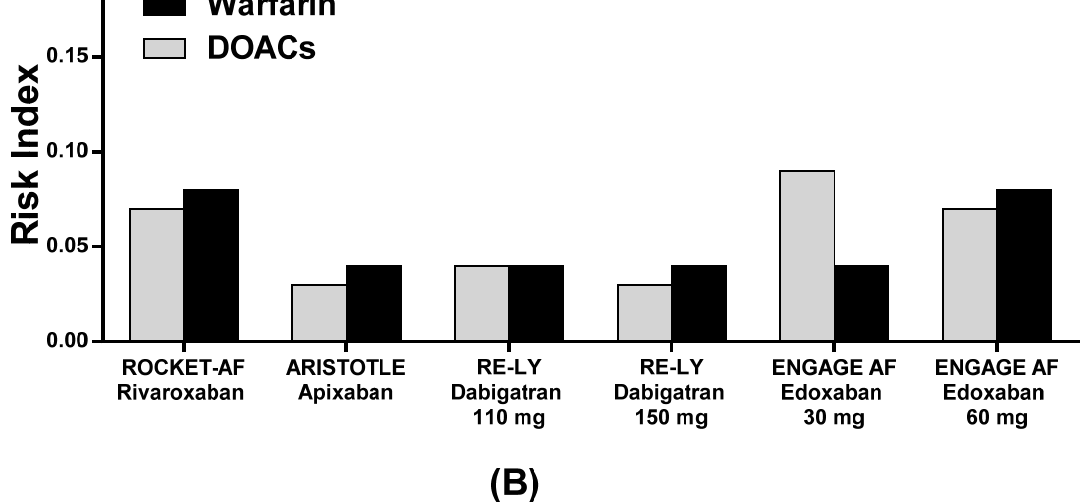
Figure 2. Risk index of stroke/systemic embolism in patients with ( A ) and without ( B ) diabetes in the pivotal trials.